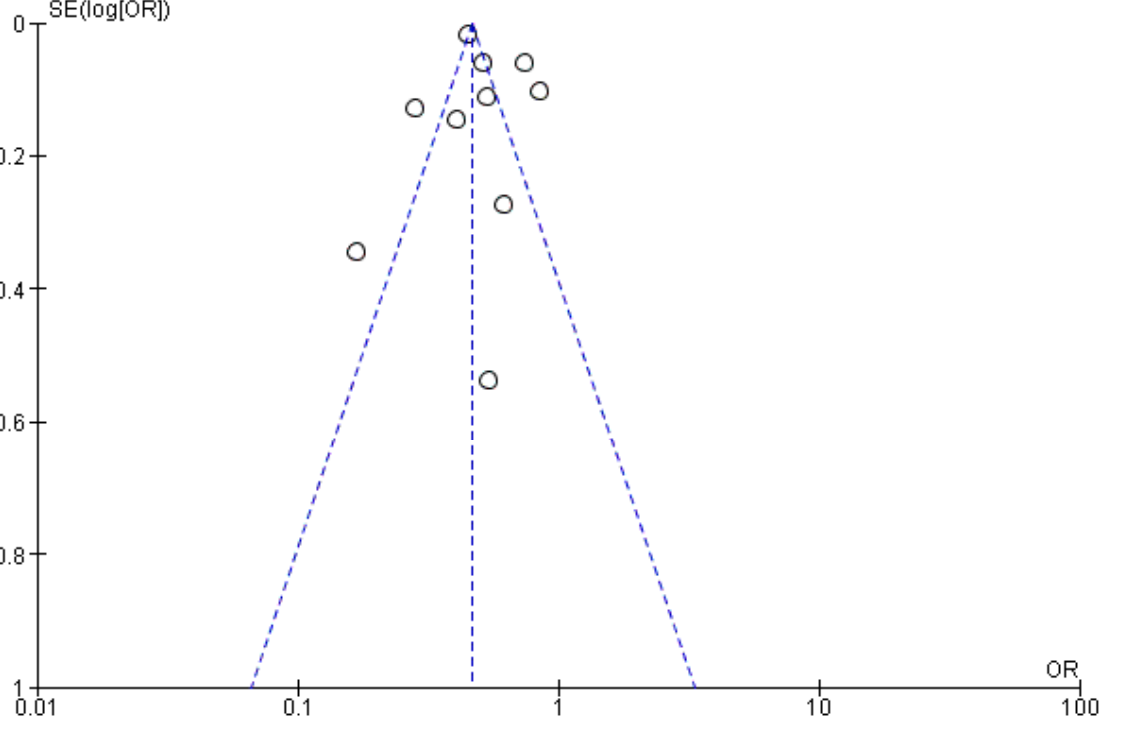
Figure 5. Begg’s funnel plot for publication bias assessment.